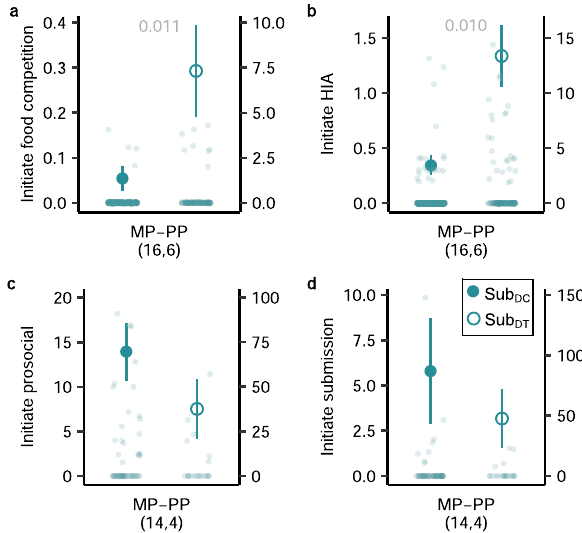
Fig. 4 Effects of the antiandrogen treatment of dominant dams on the behaviour of concurrently pregnant subordinates within the same